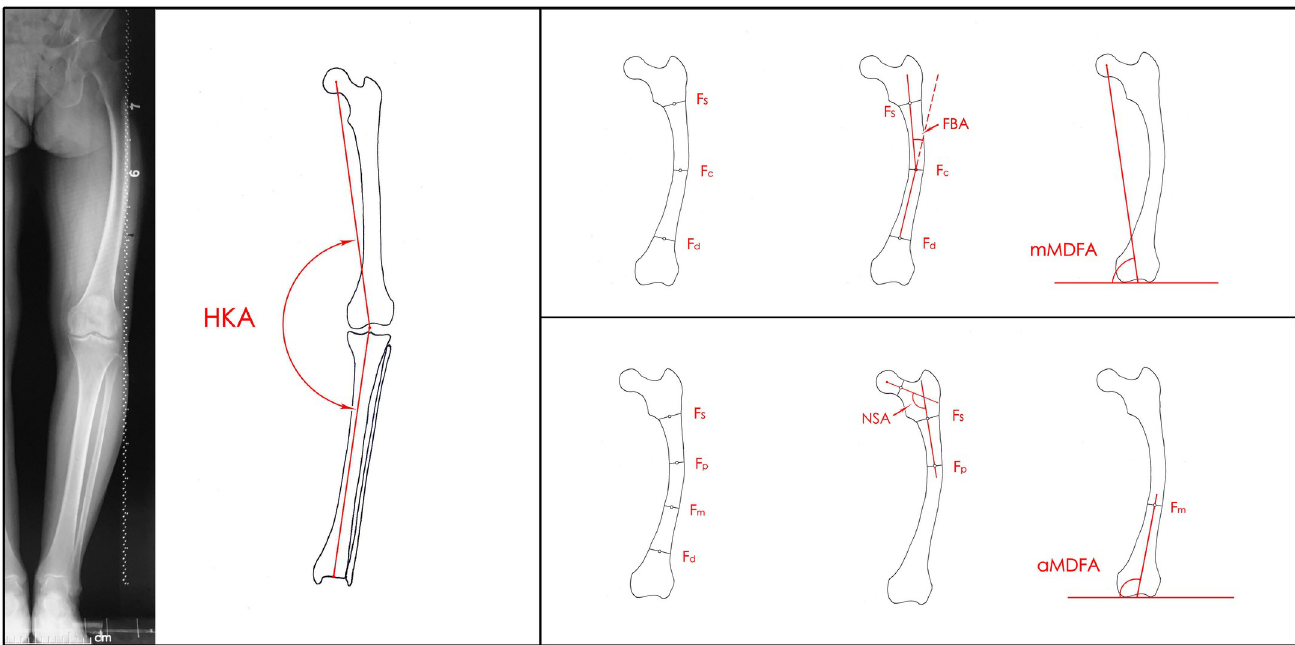
Fig 1. Radiographic measurements. HKA : hip-knee-ankle angle; Fs : a point bisecting the width of the femoral shaft at the lower junction of the lesser trochanter and the shaft; Fd : a point bisecting the width of the shaft 10 cm proximal to the knee joint; Fp : a point bisecting the width of the shaft at junction of the proximal third and the midsection; Fm : a point bisecting the width of the shaft at junction of the midsection and the distal third; Fc : a point bisecting the width of the femoral shaft midway between Fs and Fd; NSA : neck-shaft angle; FBA : femoral bowing angle; mMDFA : mechanical medial distal femoral angle; aMDFA : anatomic medial distal femoral